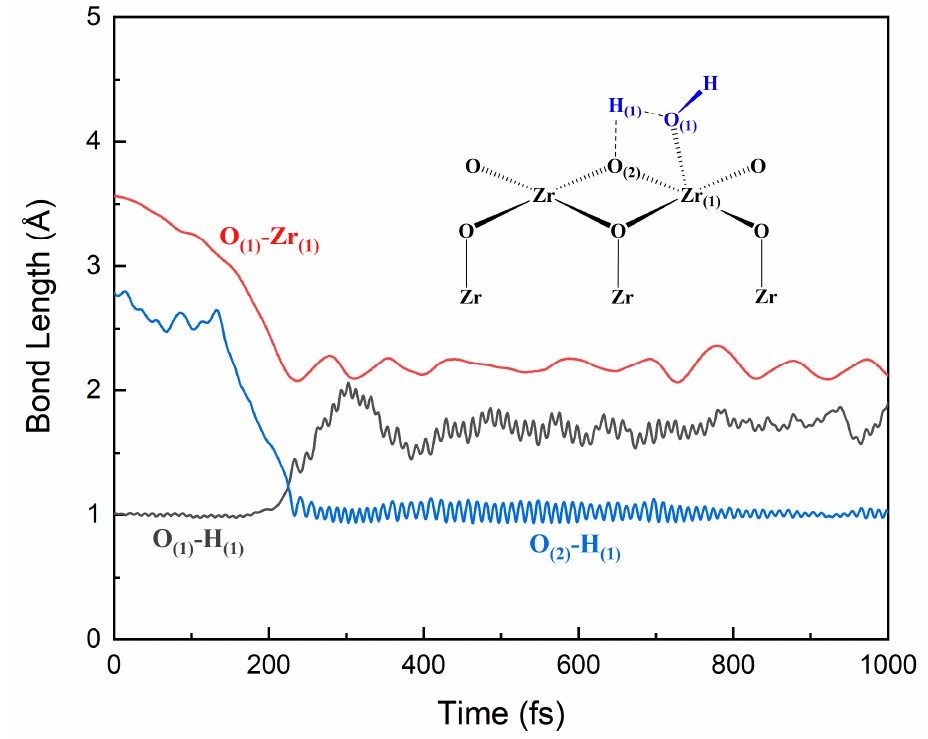
Figure 9. Evolutions of O–H and Zr–O bonds in the interface reaction between the first layer of water and the ZrO 2 surface with the five-layer ZrO 2